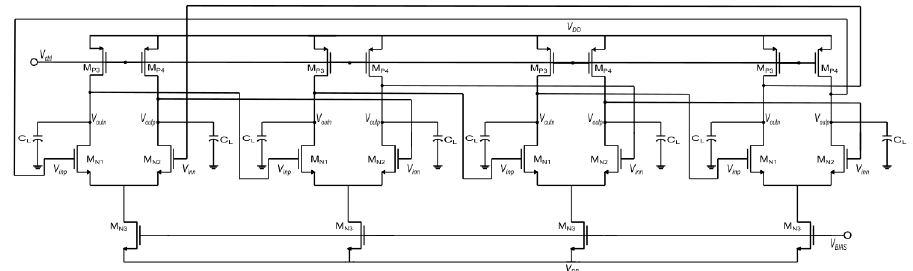
Figure 8. Voltage controlled ring oscillator consisting of four-differential stages with active